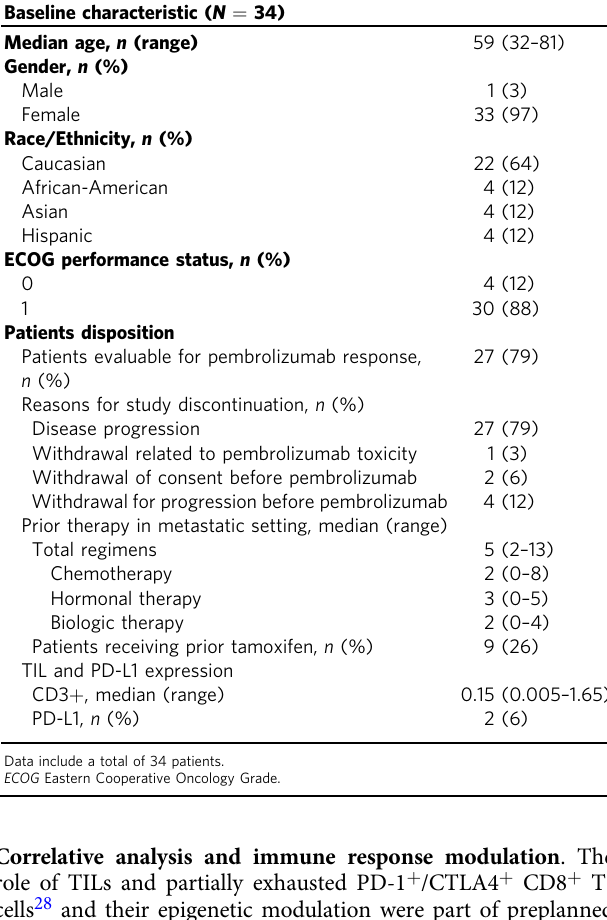
Table 1 Baseline patient demographic and clinical